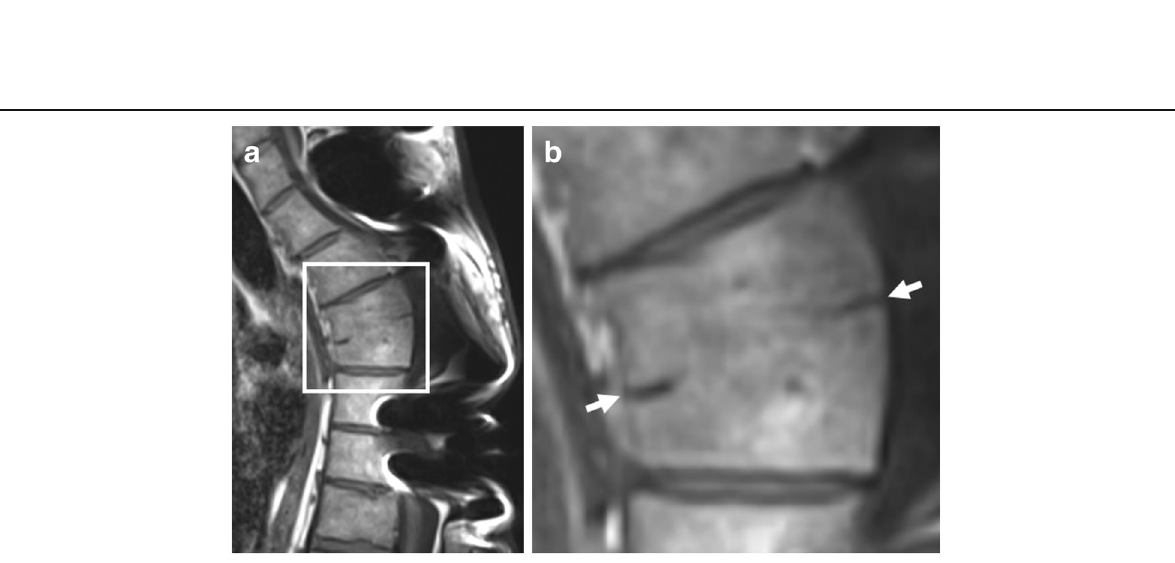
Fig. 13 Pitfalls in imaging and diagnosis of new bone formation: post-traumatic vertebral fusion. Sagittal T1-weighted MR images show interbody vertebral fusion years after severe spinal trauma, with discrete remnants of the intervertebral disc (arrows). This image suggests that the original injury included both vertebral endplates and the intervertebral disc. Also note that the height is less than the sum of the two vertebral bodies and the intervertebral disc, and antero-posterior diameter is not narrowed, two features which help differentiate this image from a congenital block vertebra. Note: b is an enlargement of the region outlined in